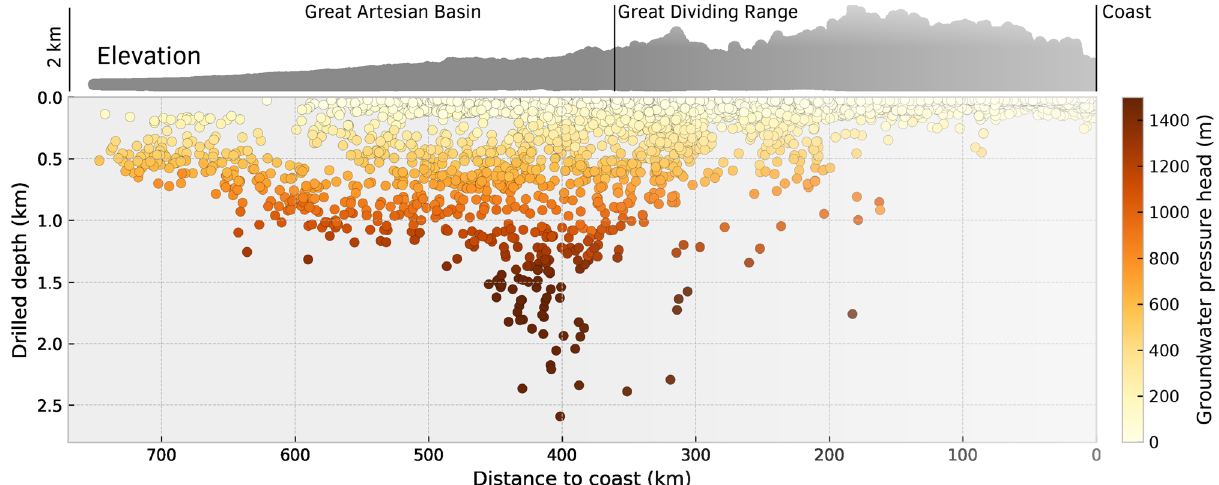
Figure 3. Mean hydraulic pressure head ( h P = P /ρ w g ) in 15,018 groundwater monitoring boreholes